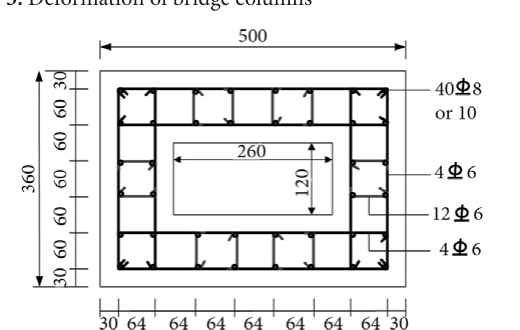
Fig. 6. Steel configuration of cross section, in mm Table. 1. Properties of the column specimens